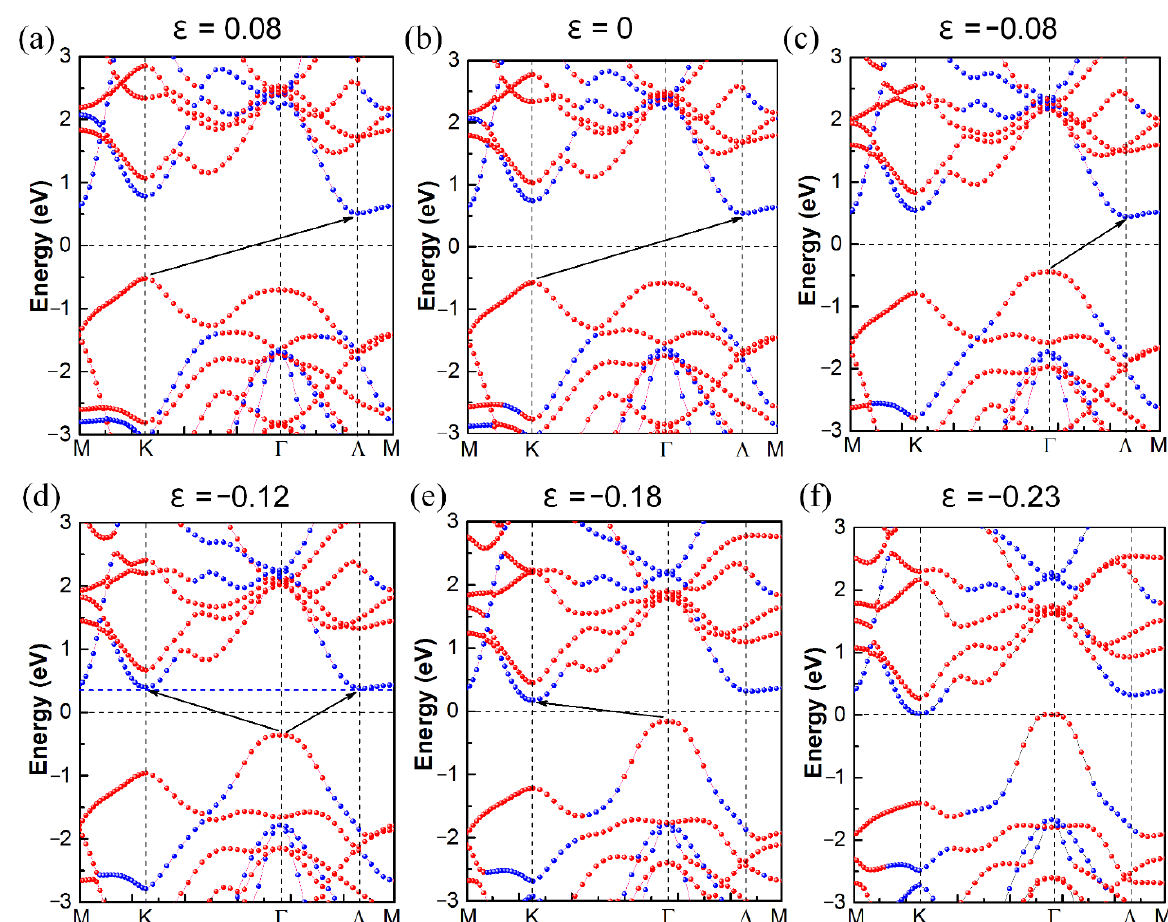
Figure 3. ( a – f ) Projected band structures of BlueP/WSe 2 vdW heterostructure under different vertical strain. The bands dominated by BlueP and WSe 2 are plotted by blue and red balls, respectively.